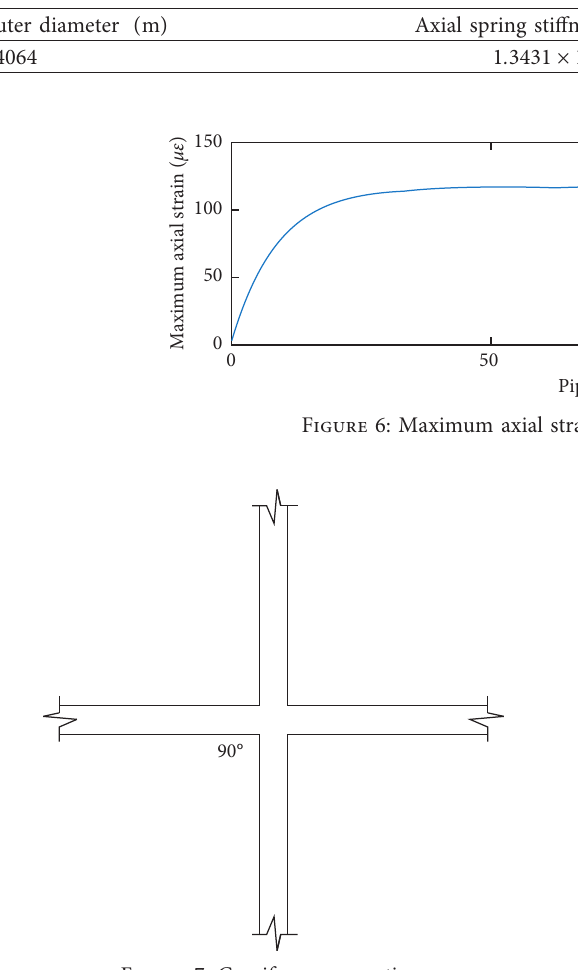
Figure 7: Cruciform